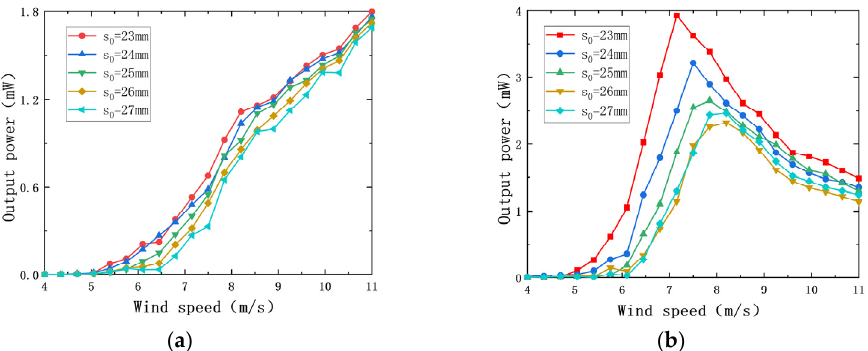
Figure 11. The variation of the output power with wind speed at different s 0 : ( a ) the PEH output power; ( b ) the EEH output power.